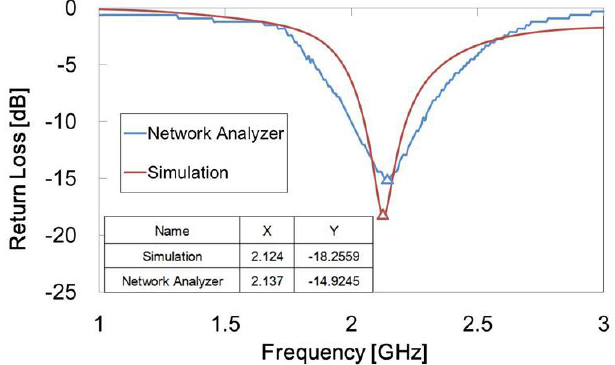
Figure 11. Line chart of experimental results compared with simulation when IPMC switch operates. The horizontal axis represents frequency and the vertical axis represents return loss.